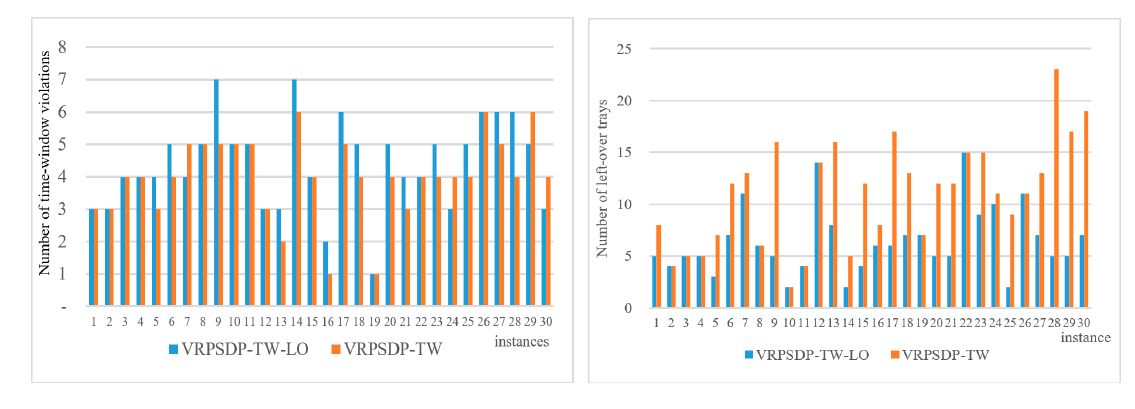
Figure 1. Performance comparison of time window violations and left-over trays.